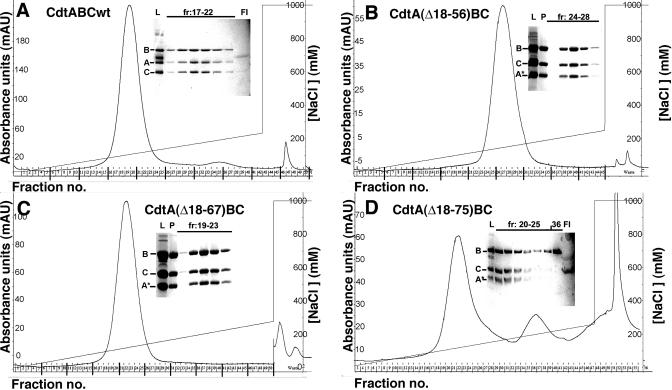
Cation-Exchange Chromatography of the CDT Holotoxin Containing N-Terminal Deletions of CdtAWild-type (A) or mutant CDT holotoxins [(B) holotoxin with CdtA (Δ18–56), (C) holotoxin with CdtA (Δ18–67), (D) holotoxin with CdtA (Δ18–75)] were run on Fast Flow SP Sepharose columns using an ÄKTA FPLC. Refolded CDT complexes were loaded and examined in a salt gradient as described in Materials and Methods. Individual fractions (5 ml) or pooled material from the elution peak were collected and examined by SDS-PAGE. Proteins were stained with Coomassie blue stain. Images of the gels are presented inside corresponding chromatograms. L, loaded material; fr, fraction number; Fl, flowthrough; P, pooled material from elution peak. Absorbance was measured at 280 nm.